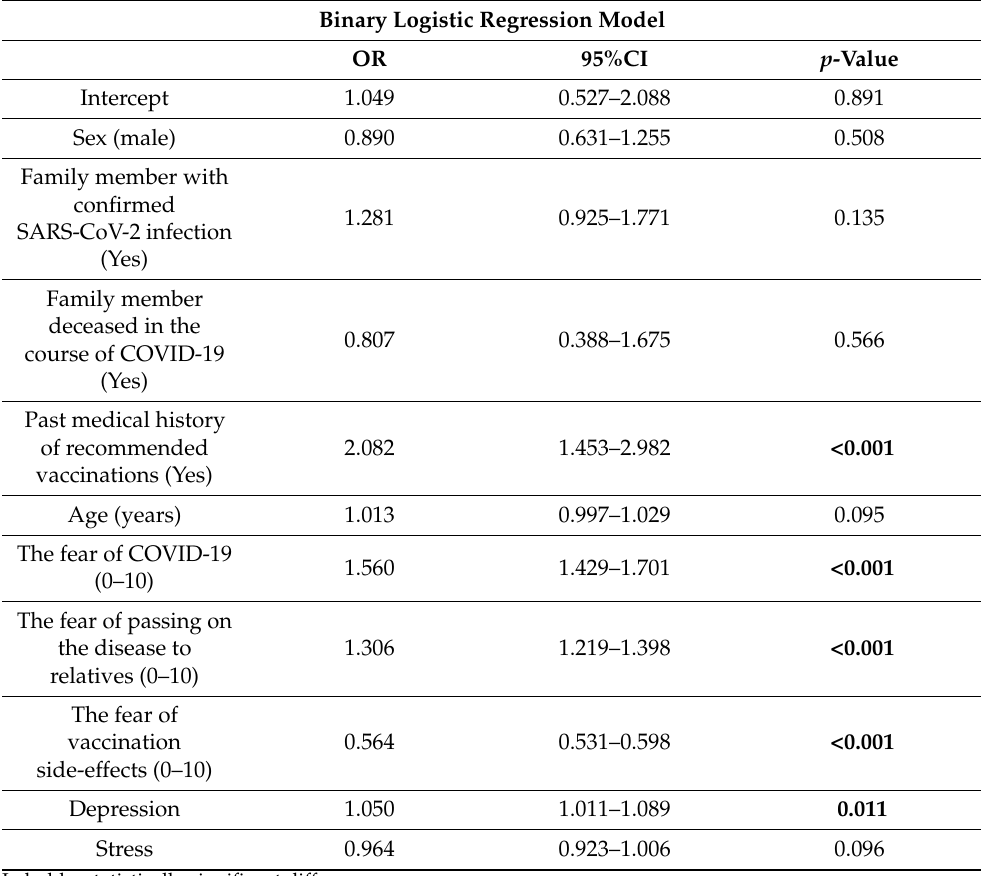
Table 6. The logistic regression model evaluated the impact of tested parameters on the willingness to get vaccinated adjusted to the baseline characteristics of the enrolled